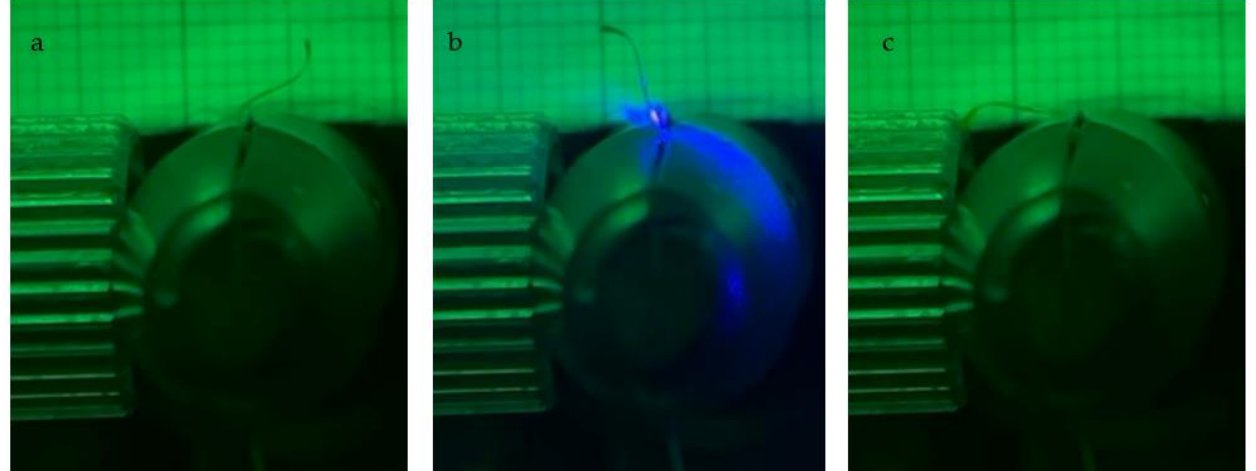
Figure 8. Movement modulation of the PMP as a function of the polarization. If the PMP is hit by a laser polarized parallel to the rubbing director, it bends toward the laser and then goes back to its initial position when the laser is turned off ( a , b ). When the PMP is firstly hit with a laser polarized perpendicularly and turned off and then hit with parallelly polarized light, the PMP changes bending direction ( c ).